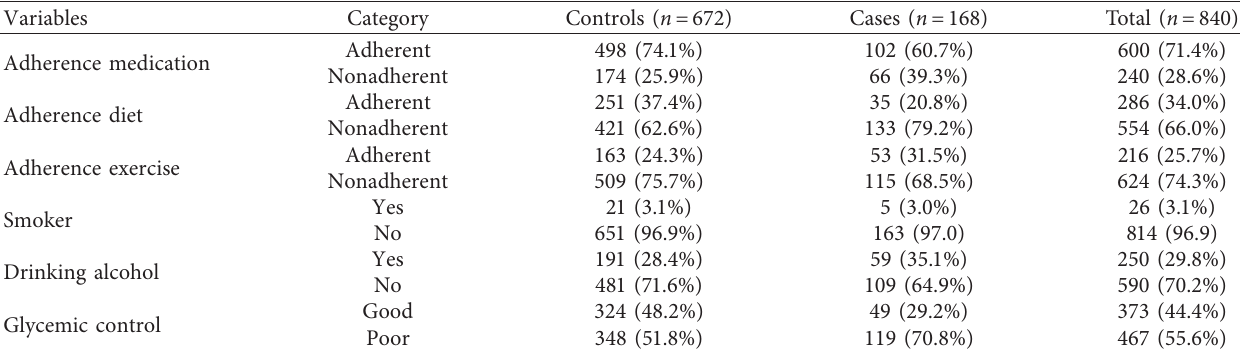
Table 3: Distribution of behavioral factors among study participants on follow-up at public hospitals of Tigray, Ethiopia 2019.